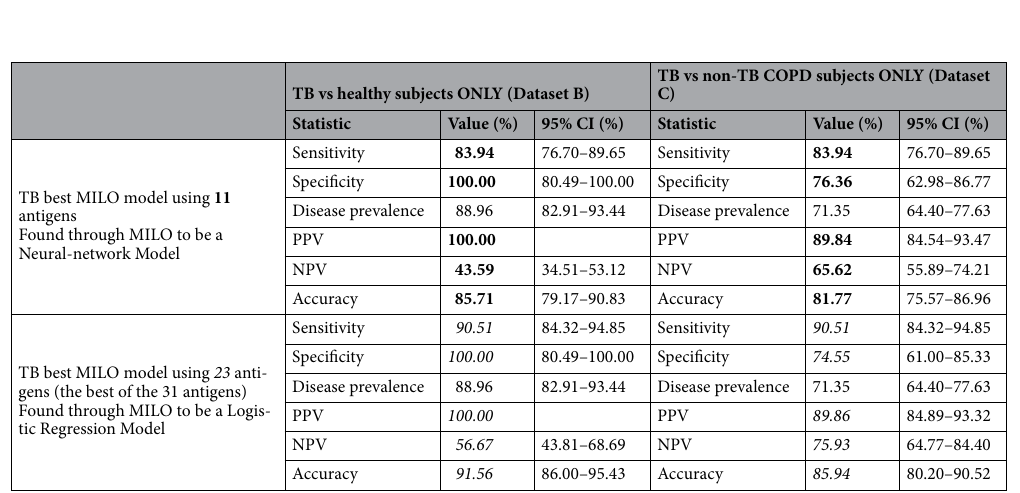
Table 4. Performance comparisons of the 11 preselected antigens vs 23 antigens selected by MILO. The bold values represent the performance measures for the best model using 11 antigens while the italicized values represent the performance measures for the best model using 23